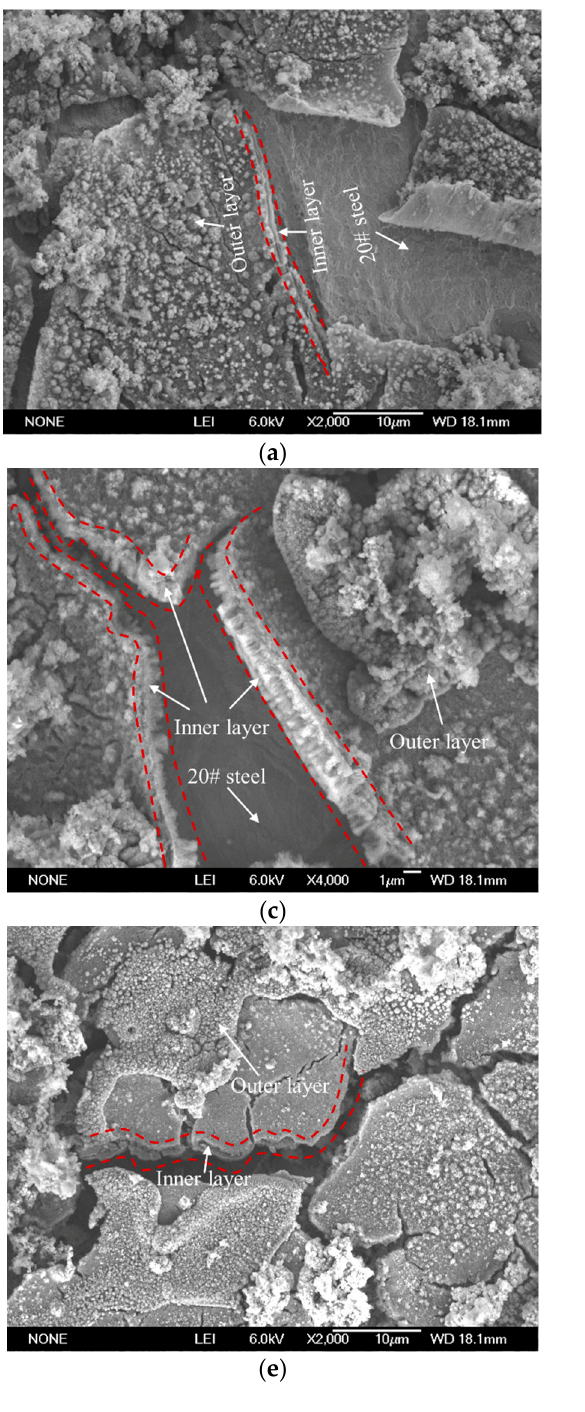
Figure 6. The local morphology of corrosion products at the black-gray area under different corrosion times: ( a ) and ( b ) 5 h, ( c ) and ( d ) 7 h, ( e ) and ( f ) 9 h.